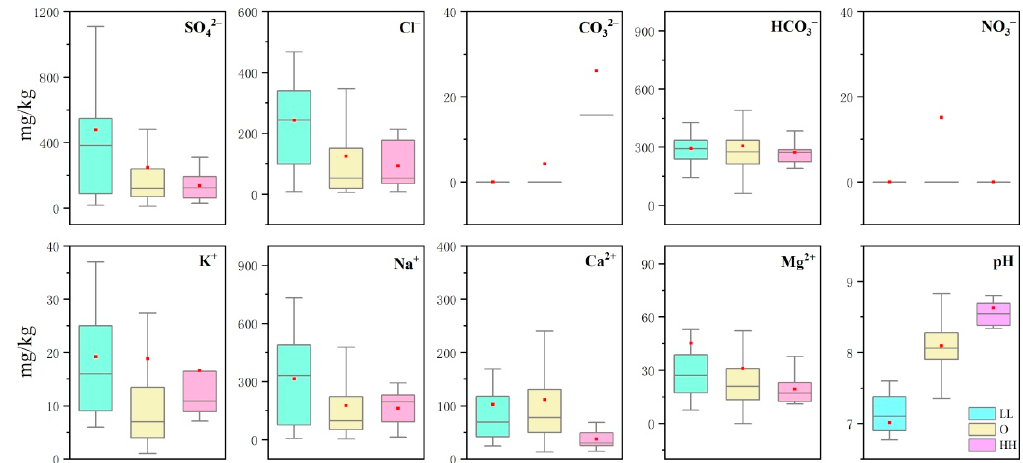
Figure 5. Box-plots showing the differences in three categories (LL, HH and O) of SO 42 − , Cl − , CO 32 − , HCO 3 − , NO 3 − , K + , Na + , Ca 2 + , Mg 2 + and pH from the sampled soils ( n = HCO 3 − , NO 3 − , K + , Na + , Ca 2+ , Mg 2+ and pH from the sampled soils ( n = 204).